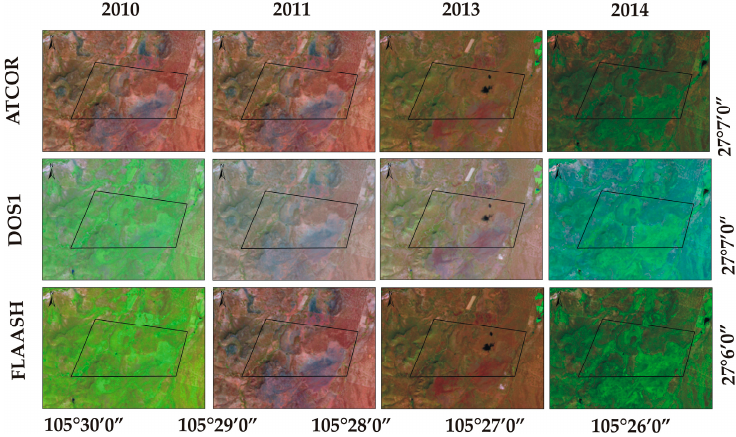
Figure 3. False-color images from the different radiometric correction algorithms. Site: Eden.